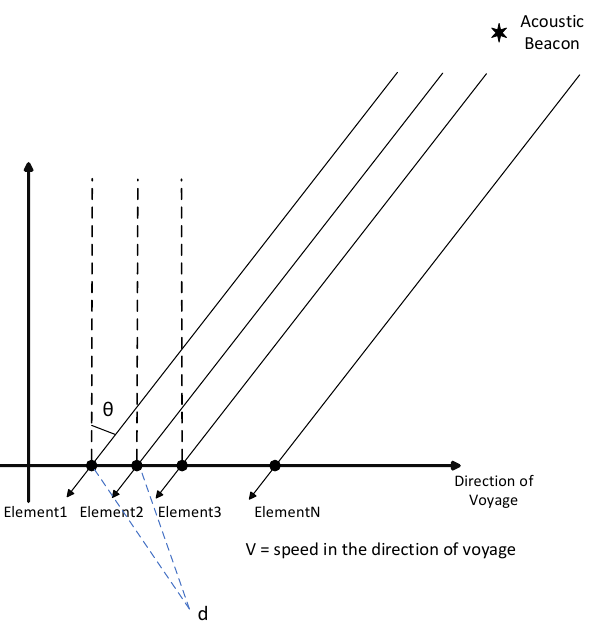
Figure 2. The basic application scenario of the moving hydrophone array. If the distance between the moving hydrophone array is long enough ( distance > ( N × d ) 2 / λ ), the reaching angle θ of the signal at each element can be viewed as the same. So, θ is defined as the bearing angle between array and beacon. The interval between adjacent elements is d . N is the number of elements. λ is the wavelength of the